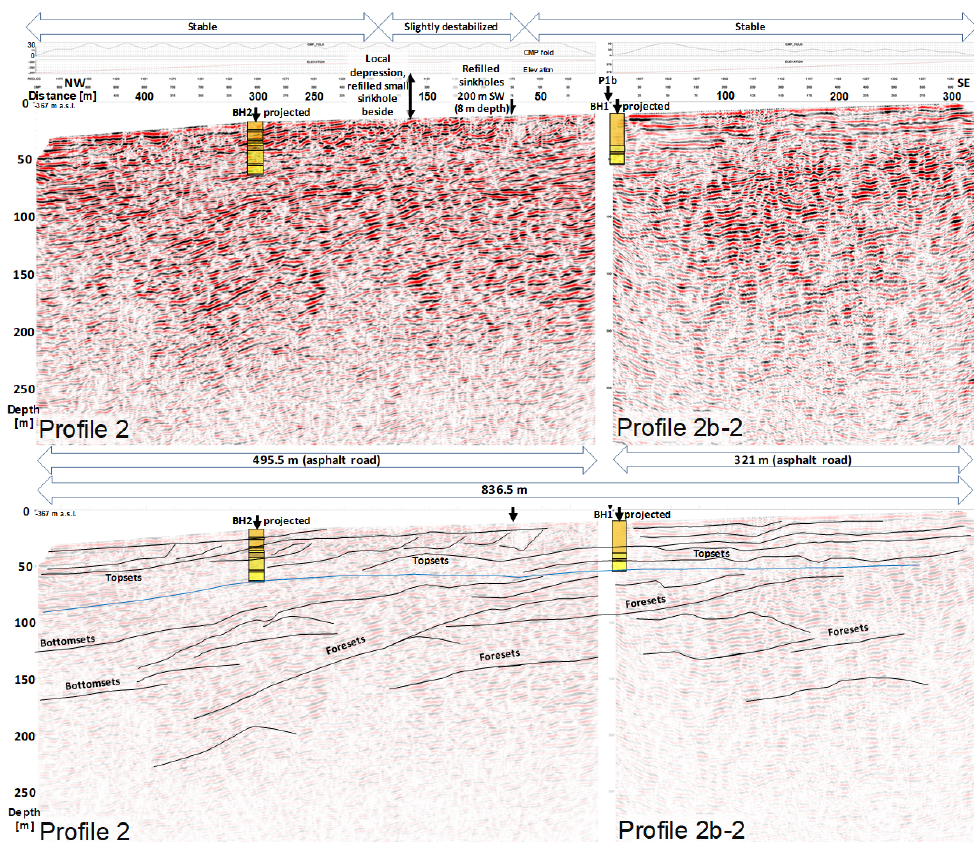
Figure 9. Resulting depth sections of combined profiles 2 and 2b-2 after post-stack FD time migration (a) and interpretation of the main struc- ture elements (b) . For annotations, see Fig. 8. Lithology of boreholes BH1 and BH2 is projected perpendicularly into the profile from 200m distance and therefore may not show the precise layering signature. Except for the top 40m, the main characteristics down to 200m show stacked sequences of northwest-dipping reflectors, which are interpreted as northwest-prograding alluvial fan sequences. The interpreted top of the silt and clay layer in BH1 and BH2 is shown by the blue